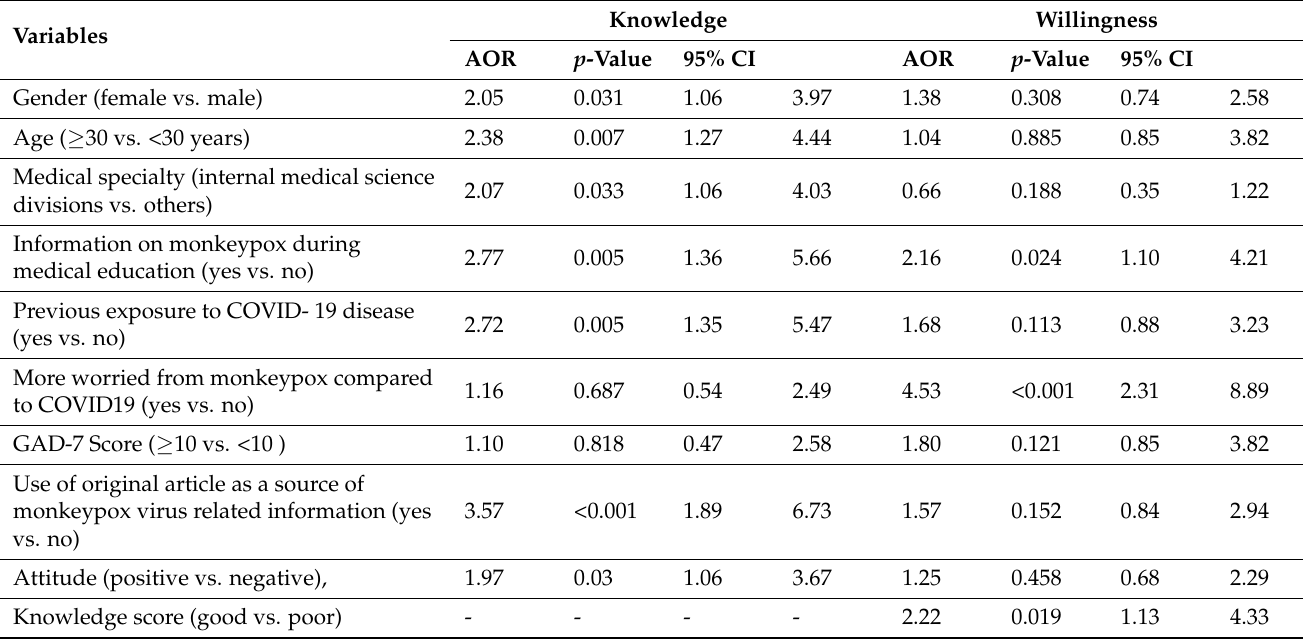
Table 5. Logistic regression analysis of knowledge and willingness to get monkeypox vaccine of physicians of